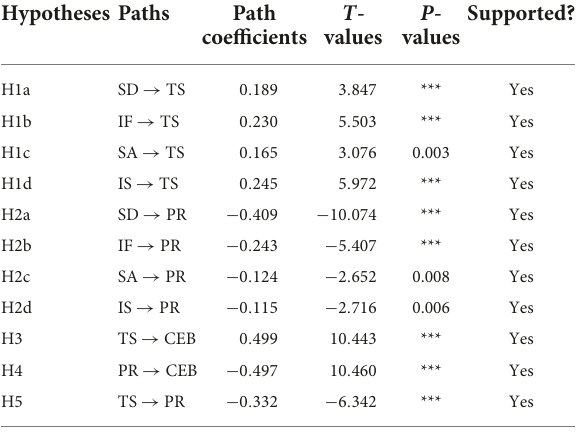
TABLE 4 Structural equation modeling results of the hypotheses.